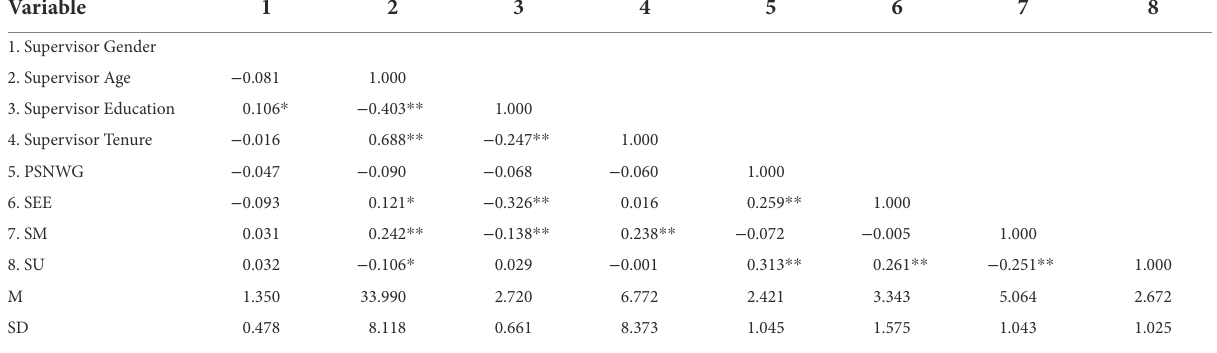
TABLE 1 Descriptive statistical analysis and correlations ( N = 362). Variable